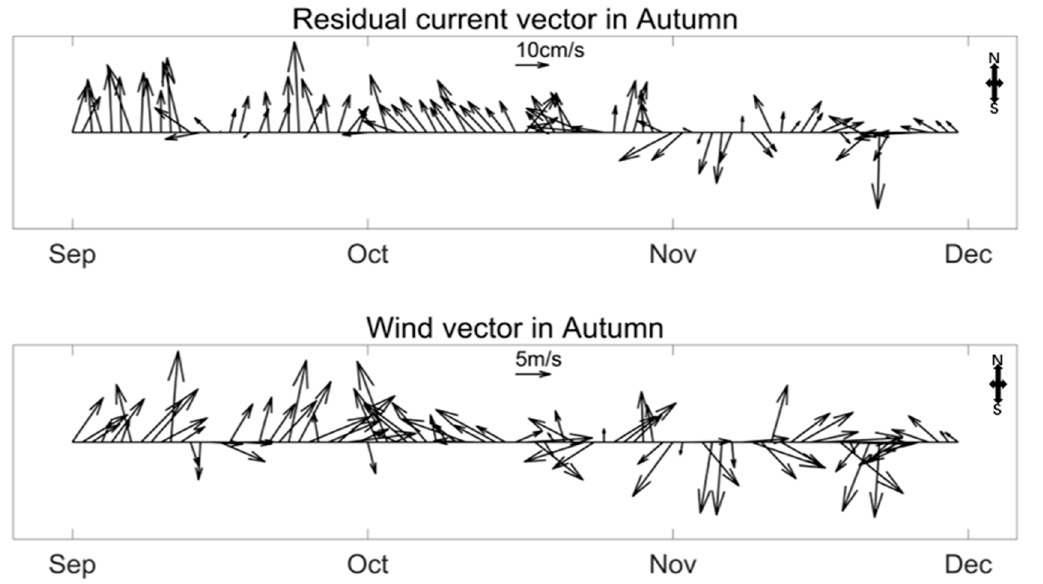
Figure 10. Vector time series of residual currents and winds in autumn.